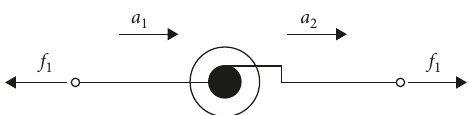
Figure 1: Mechanical model of an inerter